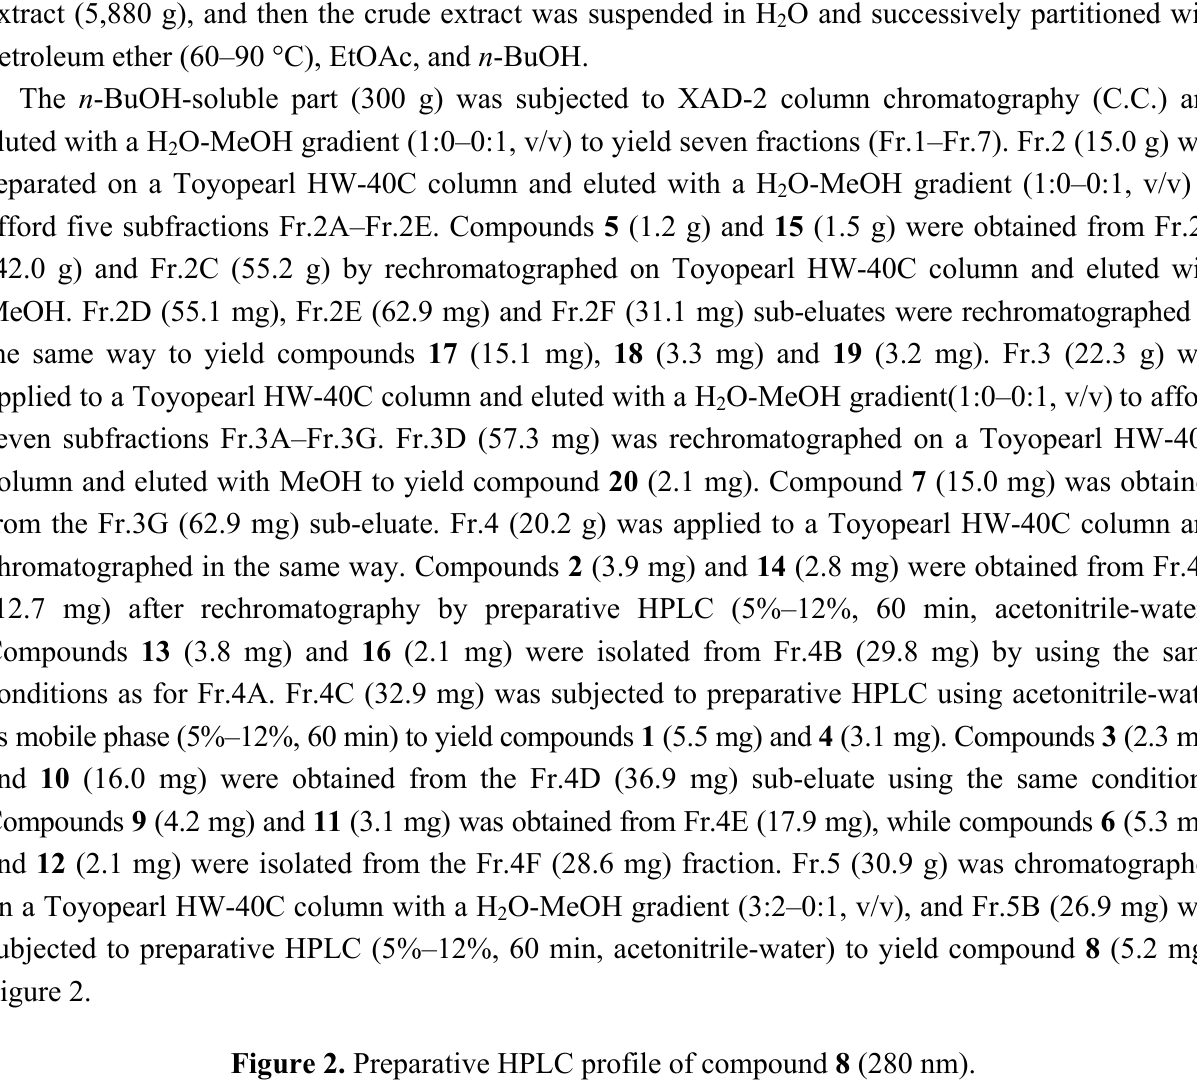
Figure 2. Preparative HPLC profile of compound 8 (280